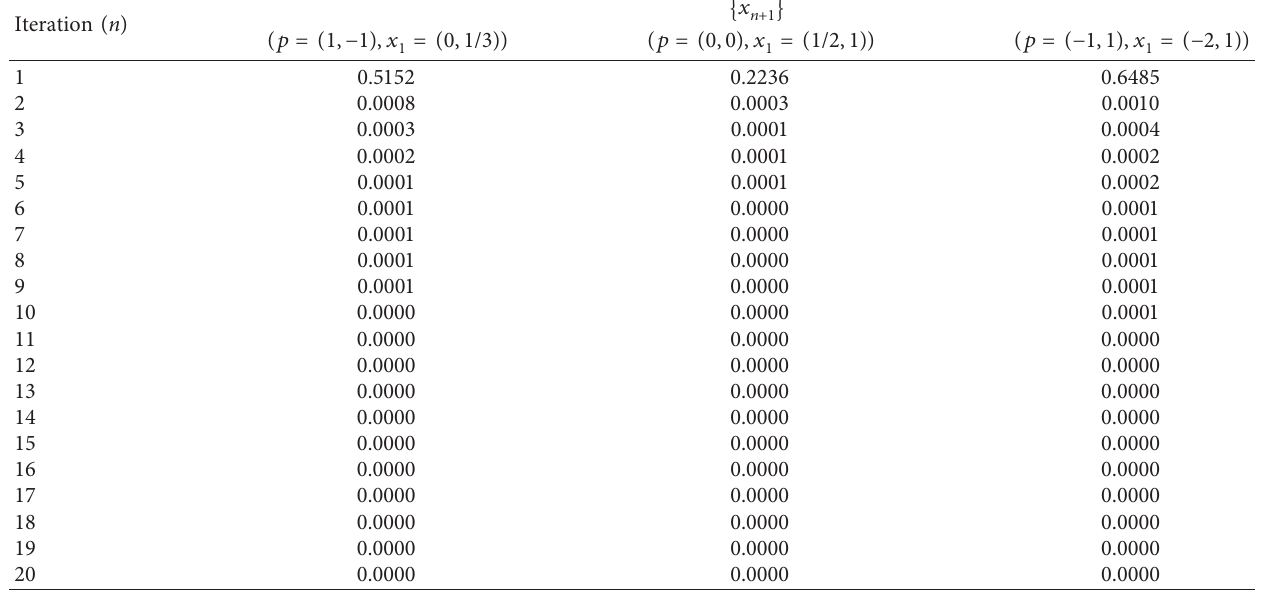
􏼈 􏼉 converges to a fixed n